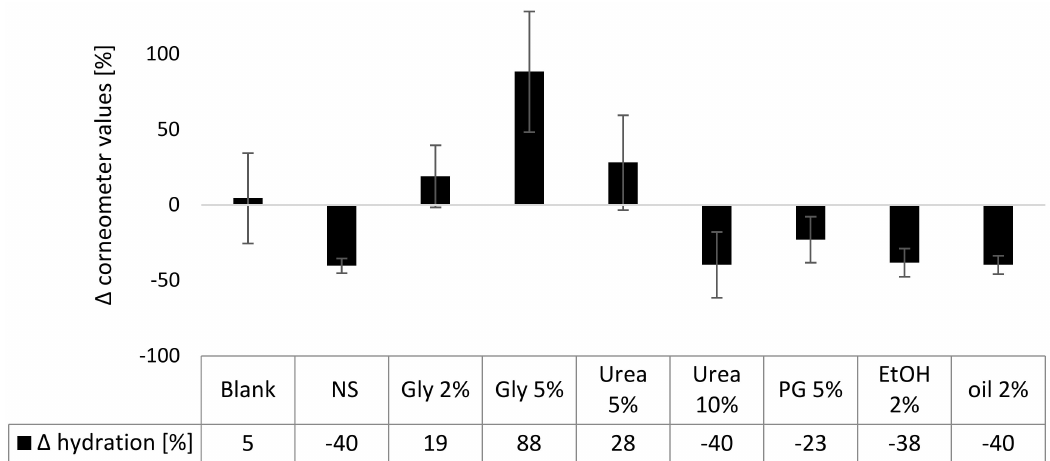
Figure 8. Influence of curcumin nanosuspension without (NS) and with di ff erent excipients on the skin hydration (Corneometer measurements. The values obtained after 6 h of incubation are expressed as relative changes compared to the untreated skin prior to the